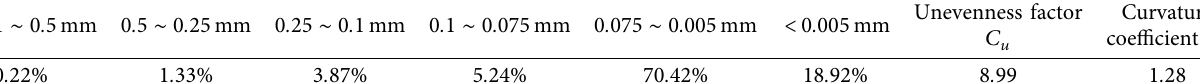
Table 2: Particle size analysis.